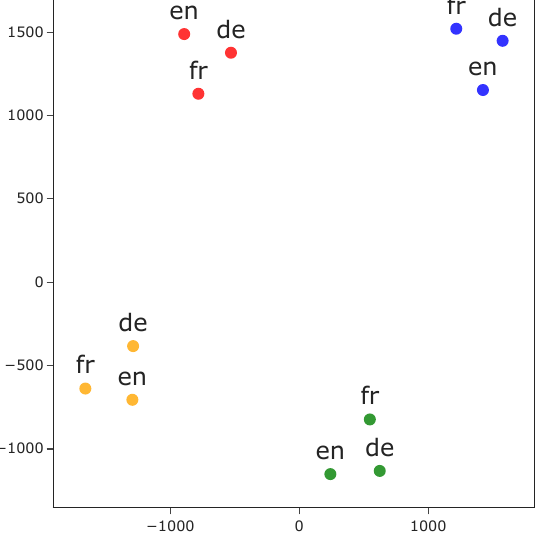
Figure 9. Interlingual embeddings from the proposed method (JM2M + DAE + TAB) for four sets of parallel German, English, and French sentences. t-SNE was used to project the 256-dimensional mean- pooled interlingual sentence embeddings to R 2 . The representative sentence colors and contents are shown in Table